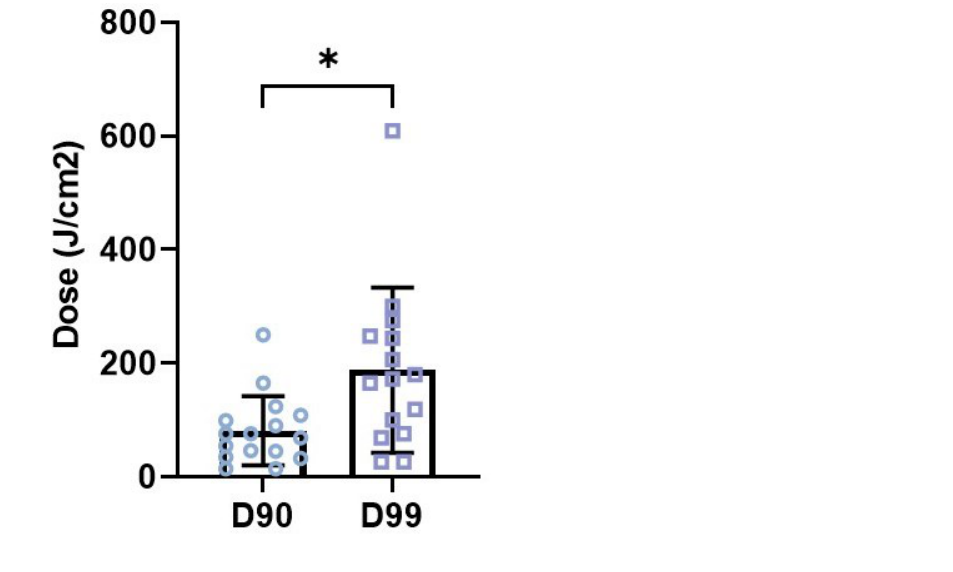
Figure 1. The recommended D 90 and D 99 of aBL treatment (at 400–420 nm) for E. coli from recent stud- ies (* significant difference ( p < 0.05); circle: D 90 from different studies (see Table 1); box: D 99 from different studies (see Table